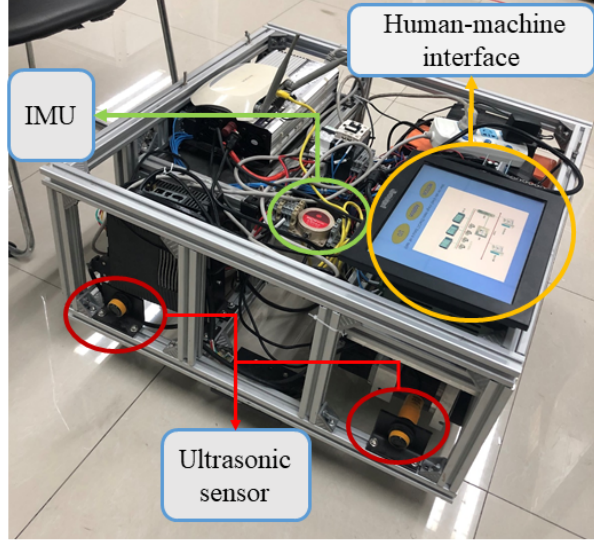
Figure 5. Platform construction of WMR for experiments.